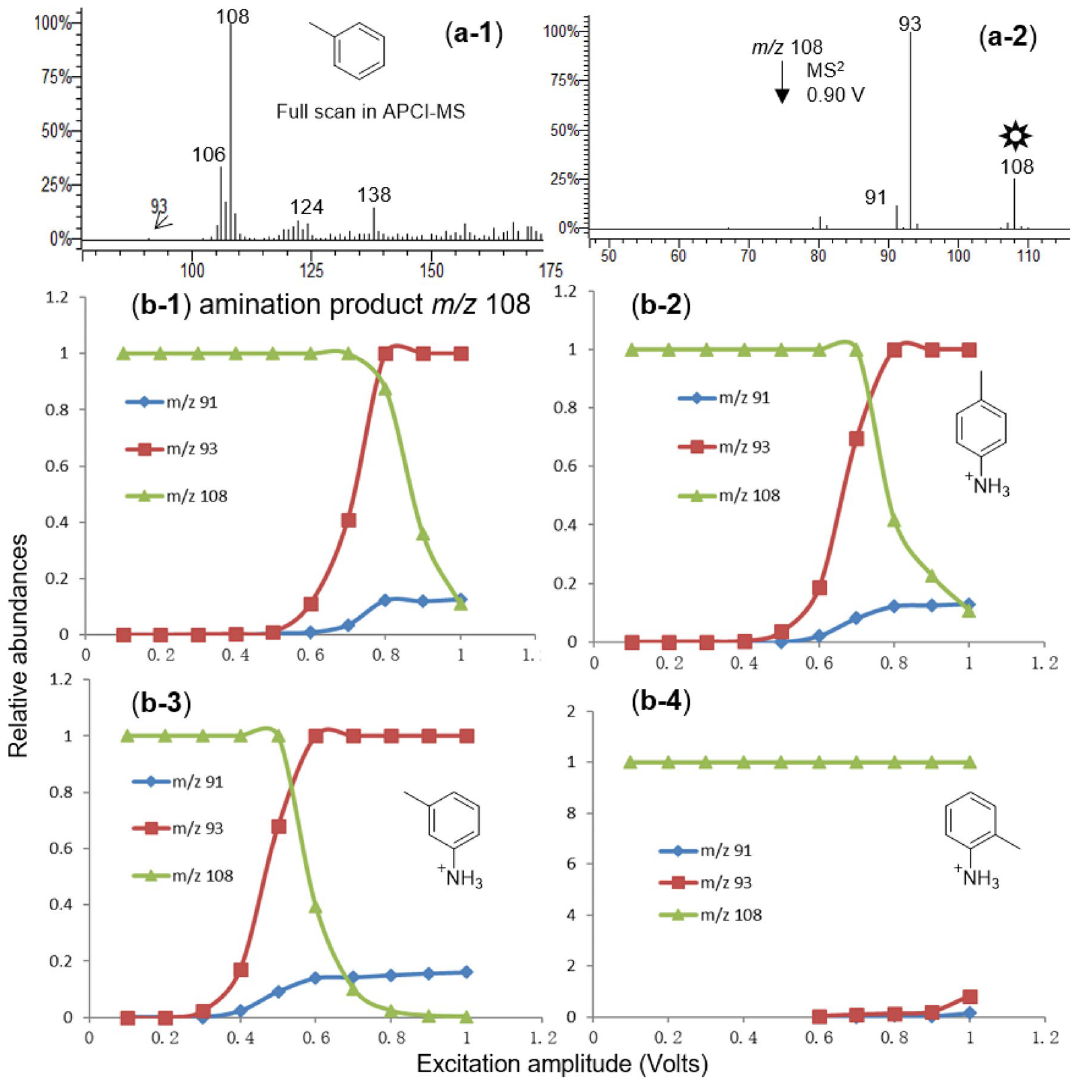
Figure 1. Full-scan and tandem mass spectra of the [M + 16] + ion of toluene ( a-1 , a-2 ) under APCI